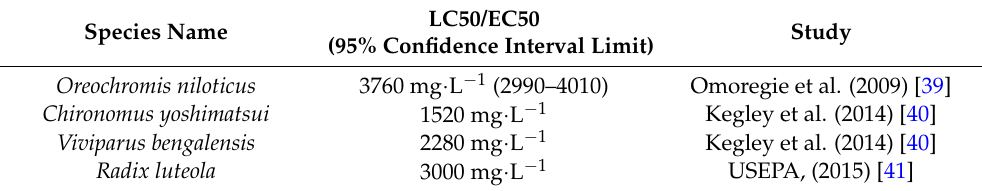
Table 9. Lethal or effective concentrations and their confidence intervals (when present, shown in parentheses) for potassium phosphate monobasic in studies with aquatic